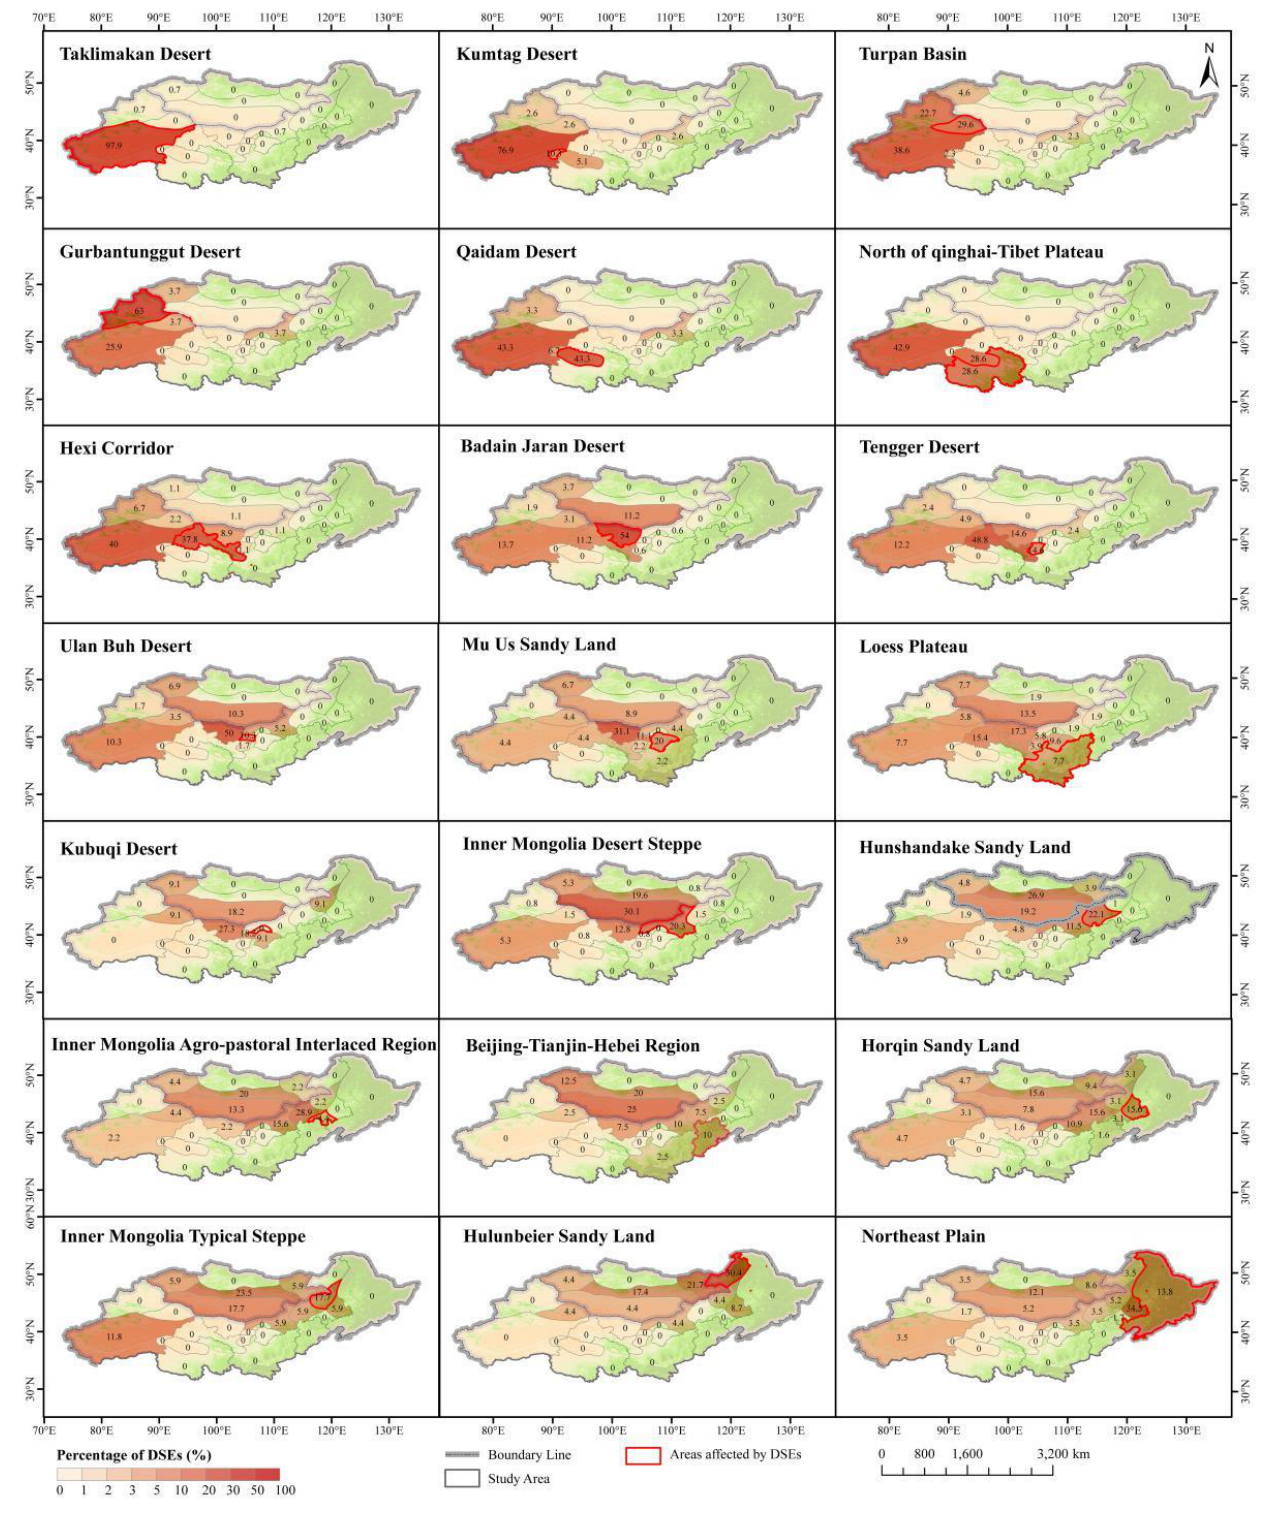
Figure 6. Statistical map of the percentage of DSEs sources in China from 2016 to 2020. The areas enclosed by red boxes are the areas affected by the DSEs, and the numbers indicate the percentage of DSEs affect the red box